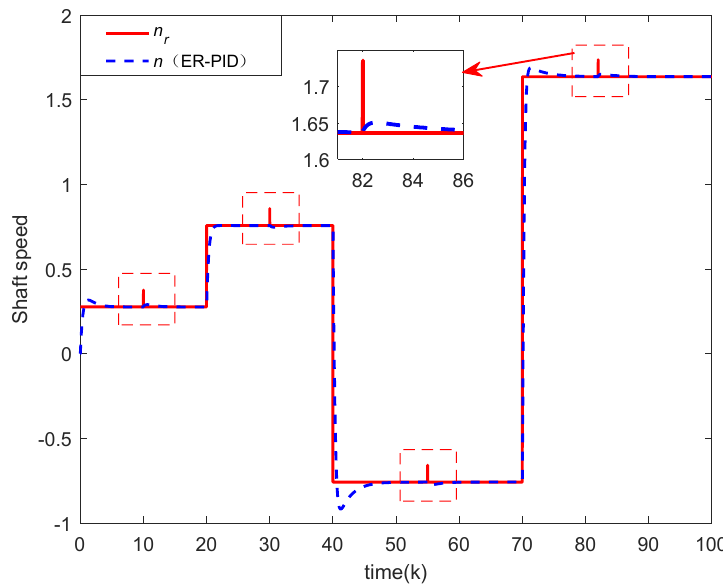
Figure 9. Tracking results of the ER-PID controller with a single-point perturbation.